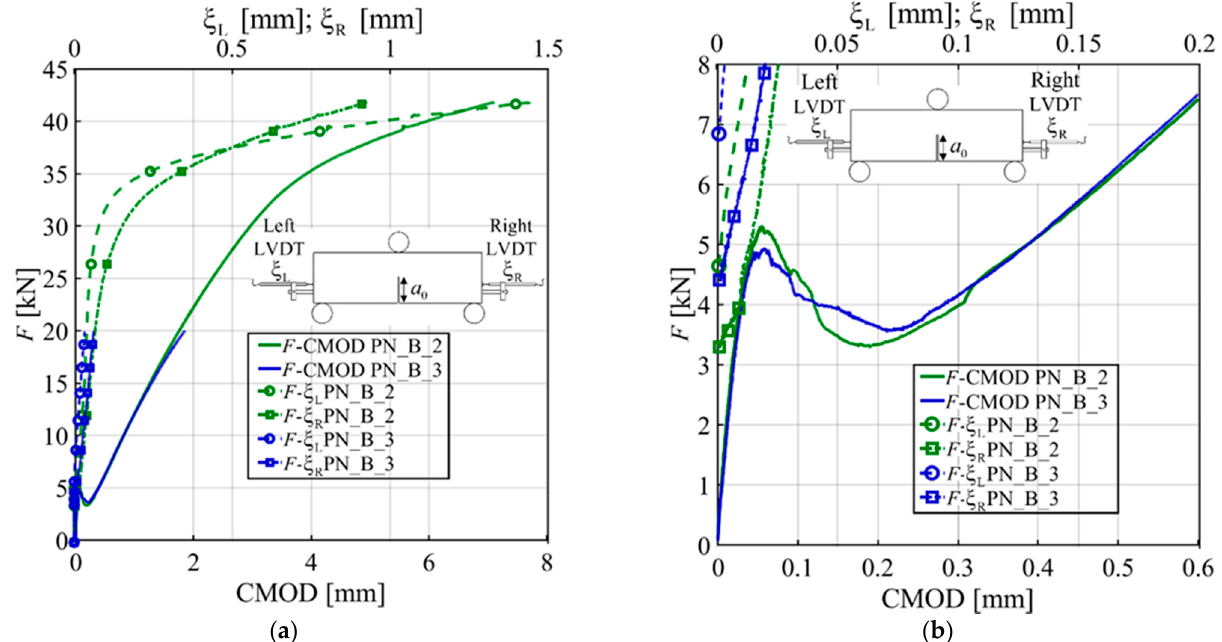
Figure 7. Plots of free end movement of GFRP bars: ( a ) F is plotted against CMOD and ξ R and ξ L for PN_B_2 and PN_B_3; ( b ) A call out for the first segment of Figure 7a.